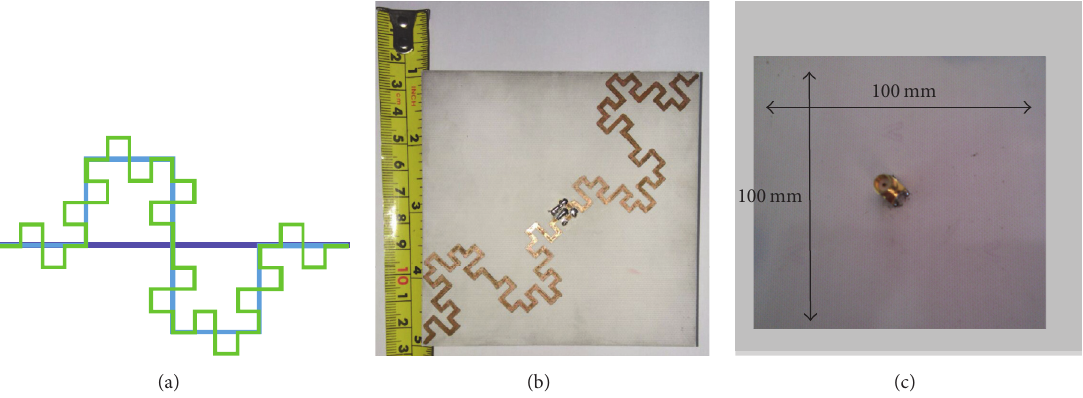
Figure 1: (a) Iterations 𝑛 = 0 , 𝑛 = 1 , and 𝑛 = 2 for a square fractal curve used as dipole arms; (b) top side of the PCB for the designed antenna; (c) bottom side of the printed fractal